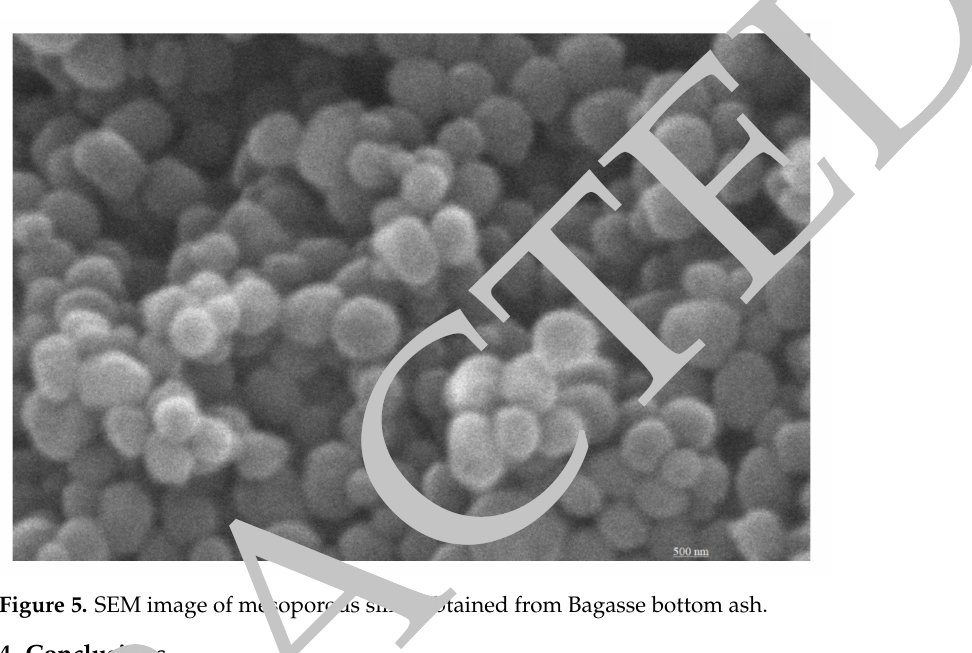
Figure 5. SEM image of mesoporous silica obtained from Bagasse bottom